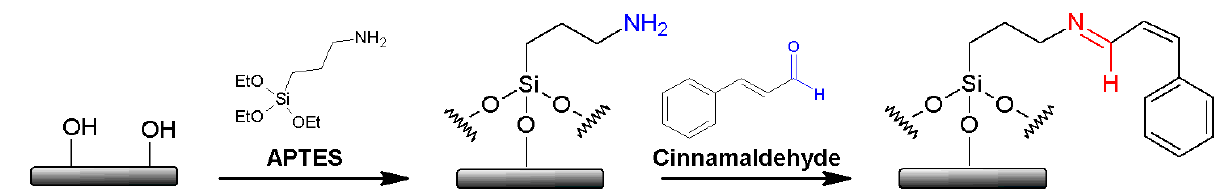
Figure 1. Scheme of the oxide functionalization with APTES and ensuing cinnamaldehyde grafting reaction. The grafting procedure here reported can be applied to different oxides and